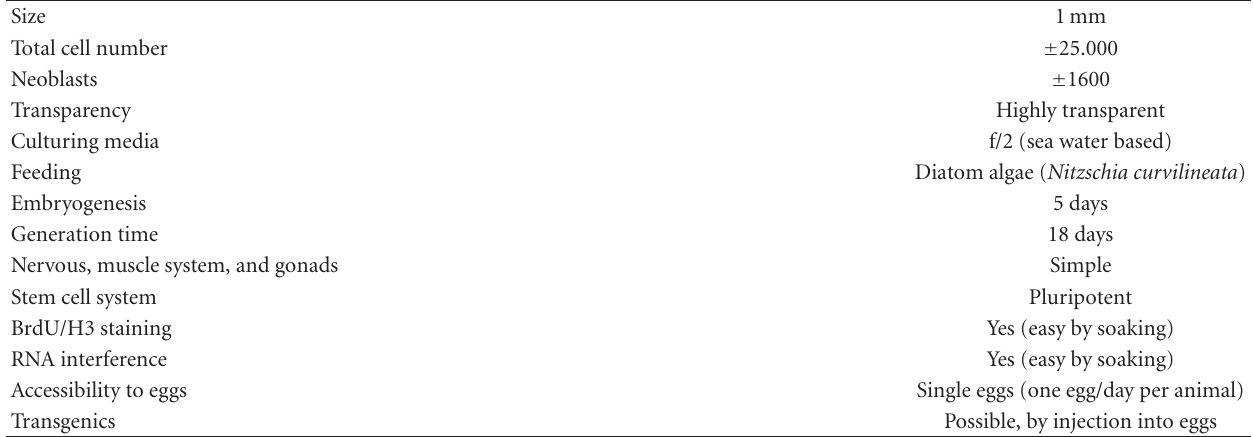
Table 1: Biological and experimental properties of M. lignano